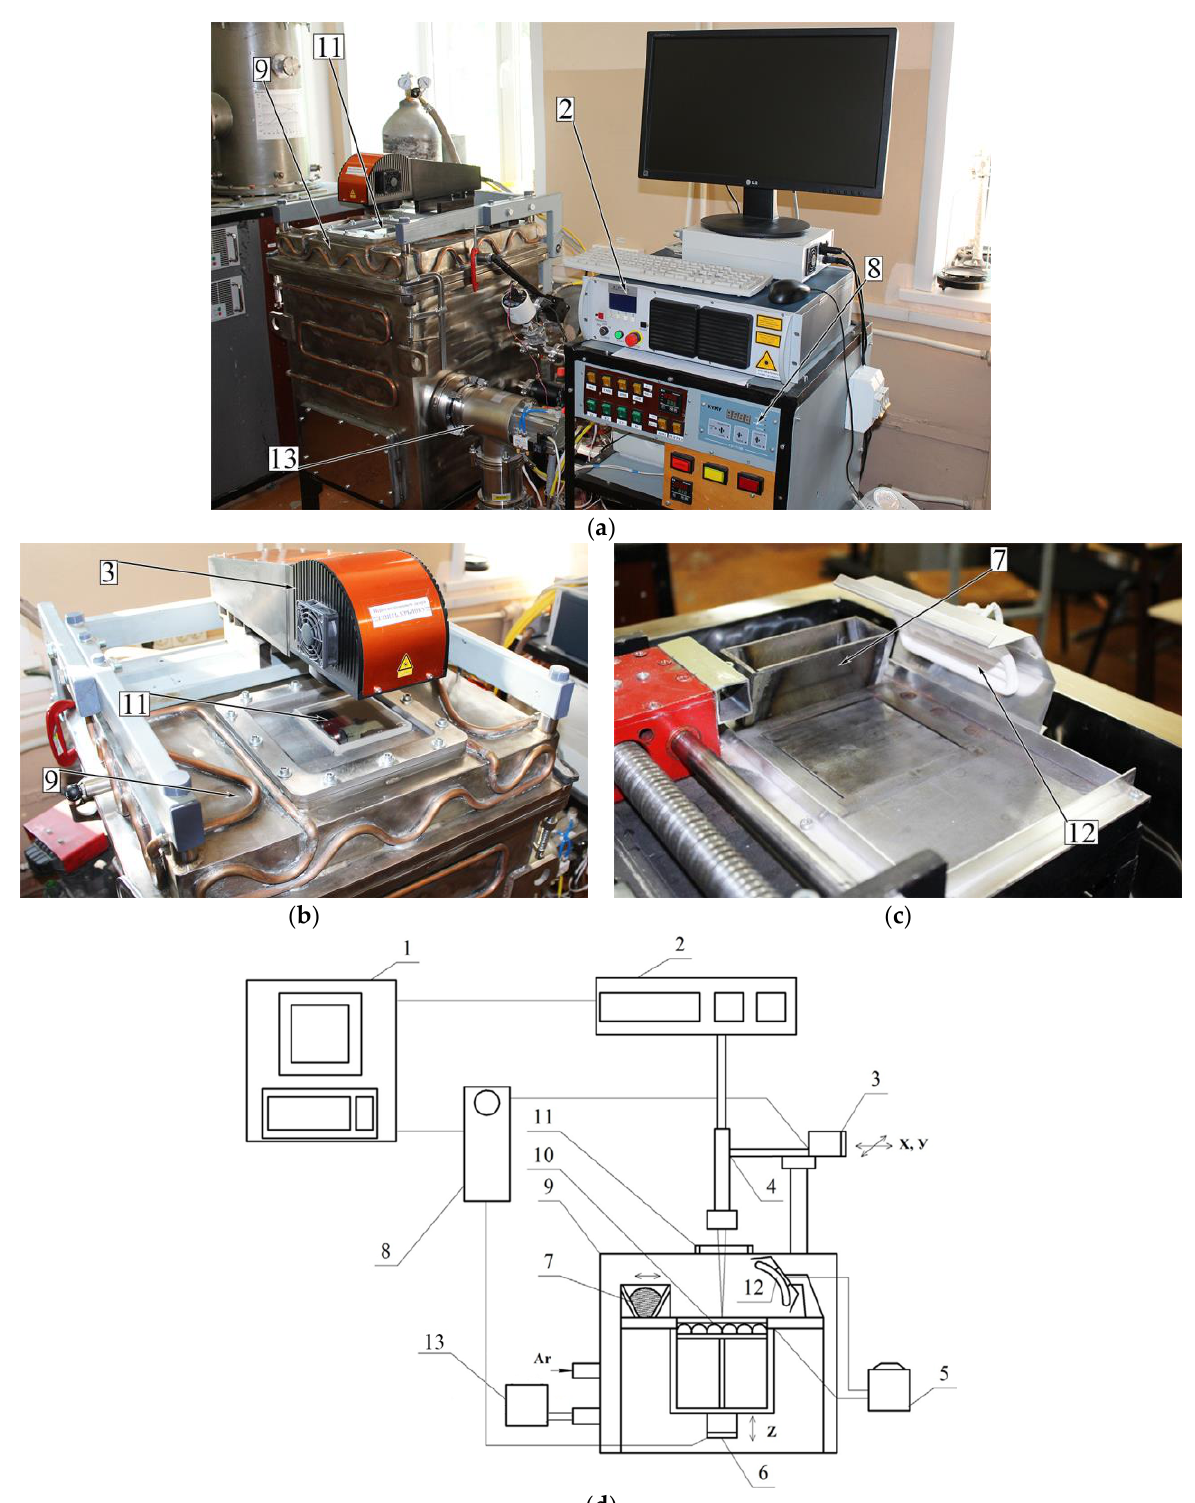
Figure 2. VARISKAF-100 MVS machine: ( a ) overall view, ( b ) scanning system, ( c ) feeder, ( d ) schematic view; 1—computer; 2—laser; 3—system providing X-Y laser displacement; 4—collimator; 5—substrate temperature control system; 6—system providing displacement of the baseplate along Z axis; 7—feeder; 8—CNC; 9—vacuum chamber; 10—spiral heater; 11—chamber window; 12—infrared heater; 13—vacuum pump.